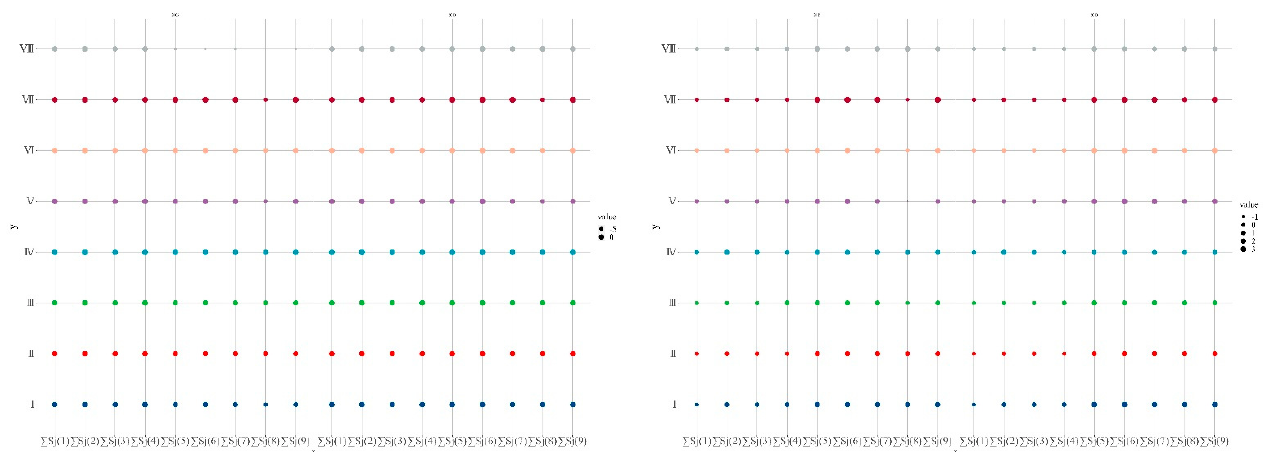
Figure 3. Relative efficiency analysis of composite DEA—cumulative value matrix bubble plot.